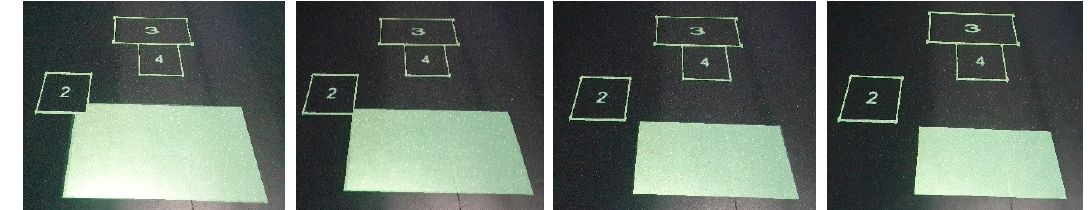
Figure 7. Four frames from the radial animation showing a solid outline shrinking down around an object selected by the user. The reflection is from a skylight and is not part of the indicator.